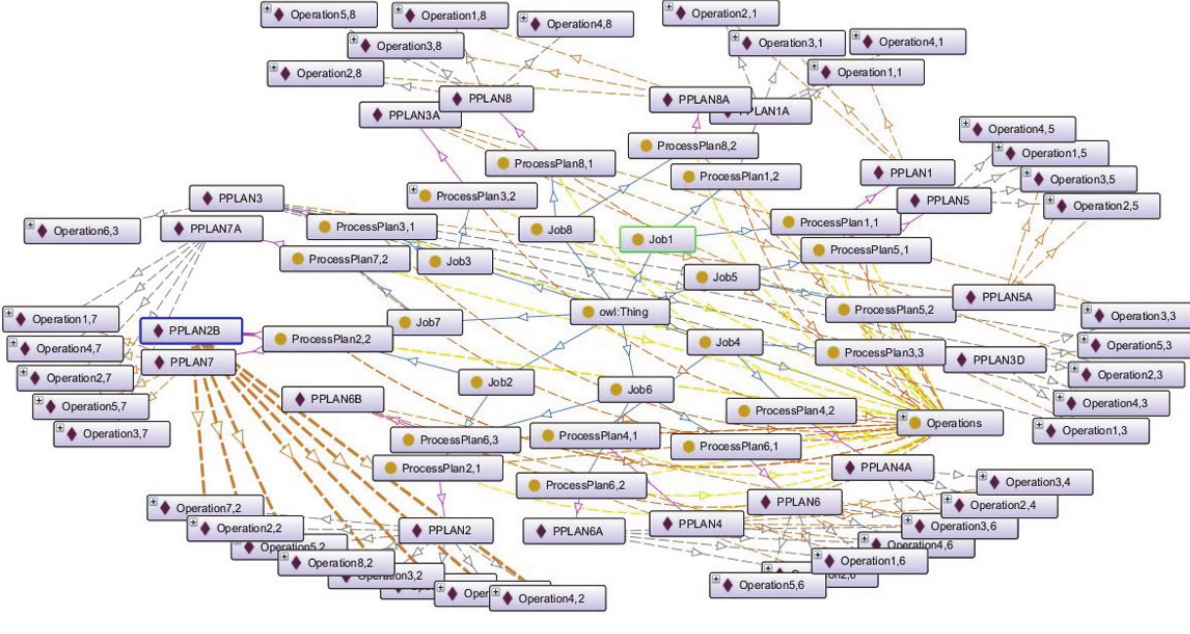
Figure 3: Development of Ontology.